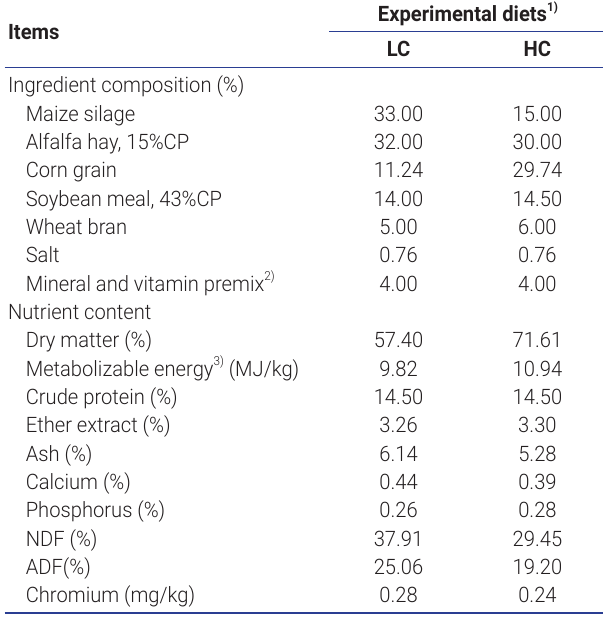
Table 1. Ingredient proportion and chemical composition of the ex- perimental diets (% DM basis)